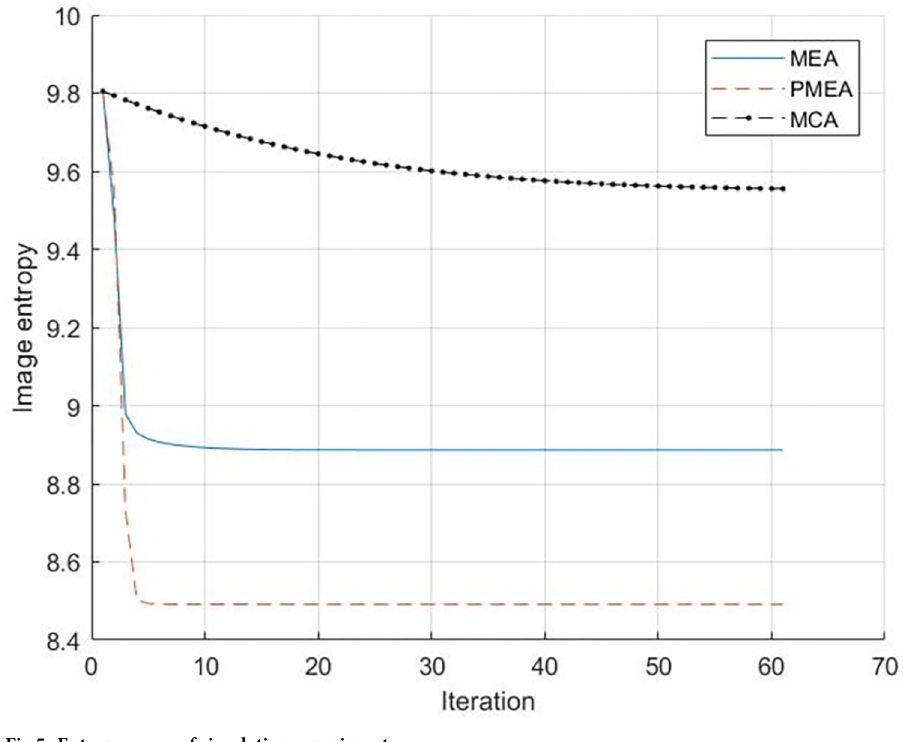
Fig 5. Entropy curve of simulation experiment.